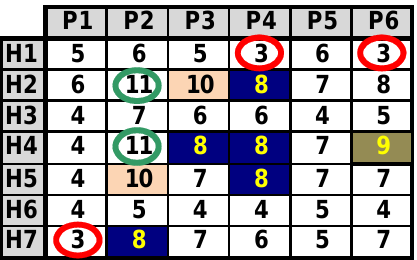
Table 4. “Crossed table of tools and detected